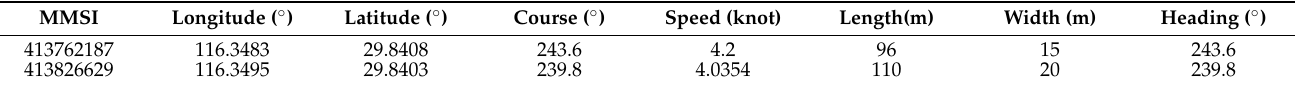
Table 2. AIS data of Case 1.